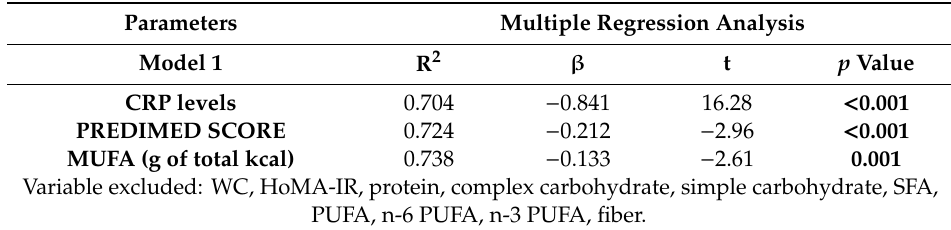
Table 6. Multiple regression analysis model (stepwise method) with the Testosterone as dependent variable to estimate the predictive value of food items of WC, PREDIMED score, CRP levels, HoMA-IR and nutrients intake (protein, complex carbohydrate, simple carbohydrate, SFA, MUFA, PUFA, n-6 PUFA, n-3 PUFA, fiber).